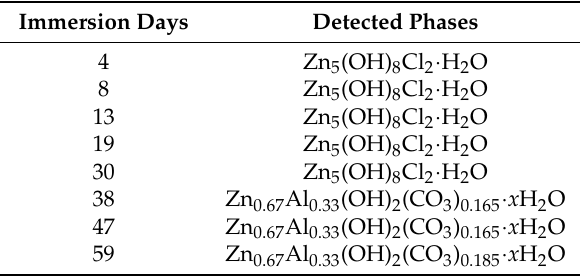
Figure 8. Mass loss of immersion specimens. Table 2. The corrosion products of the 55AZS specimen.